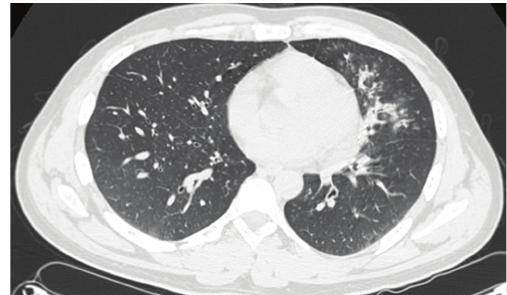
Figure 1: CT Chest of the first patient showing di ff use interstitial thickening, patchy infiltrates and areas of consolidation of the left lower